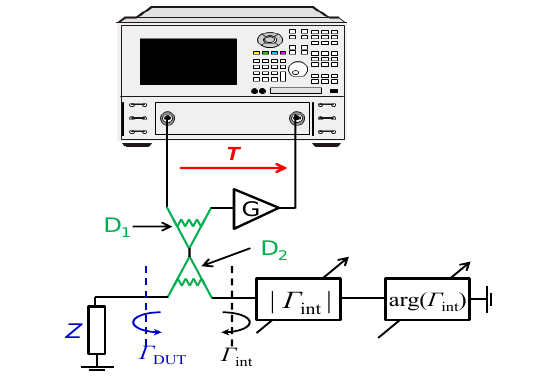
Figure 2: High impedance measurement